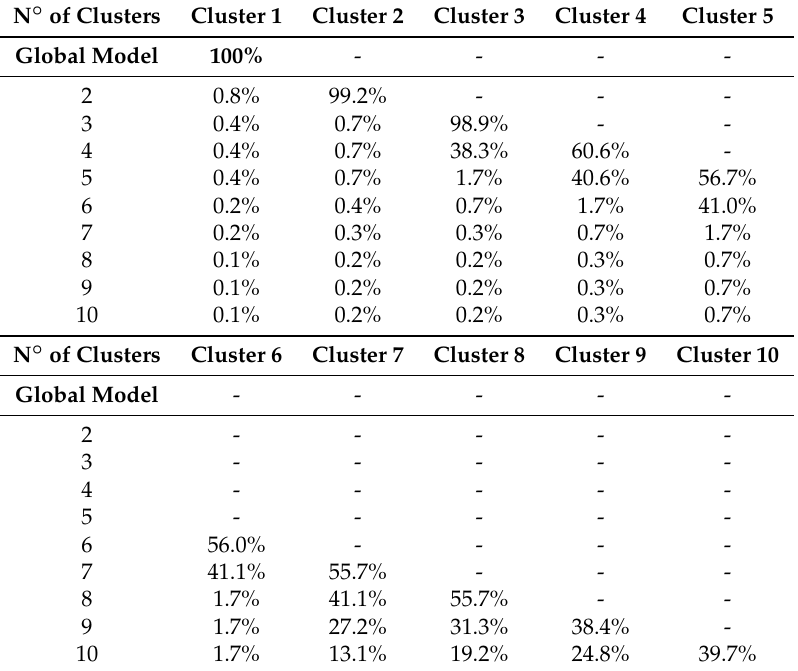
Table 1. Number of samples in each cluster in